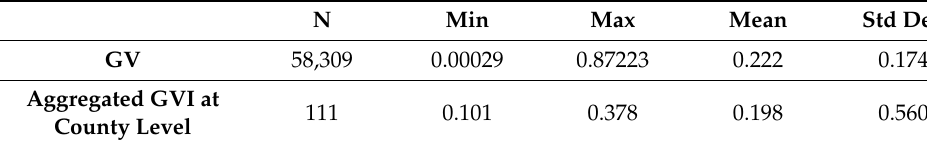
Figure 7. Green-view value of each sampling point. Table 3. Descriptive statistics of green-view values. Table 3. Descriptive statistics of green-view values.